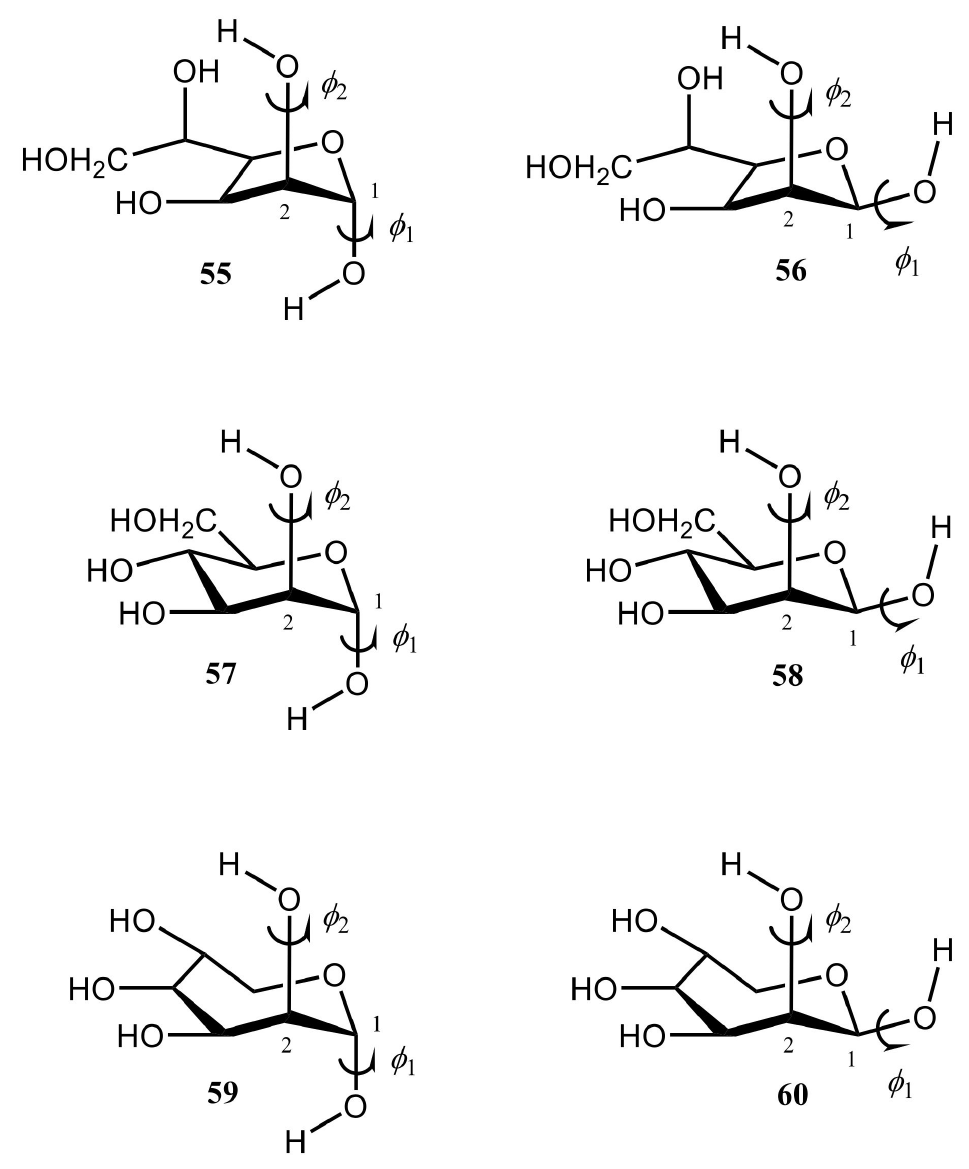
Figure 28. Structural formulas of α - and β -D-mannofuranoses ( 55 and 56 ), α - and β -D-mannopyranoses ( 57 and 58 ), and α - and β -D-mannoseptanoses ( 59 and 60 ). All rotational surfaces were characterized by the well-defined four maxima and four minima, which was due to the fact that rotation of the hydroxyl groups exercised an appre- ciable effect on 1 J (C-1,C-2) coupling constants in the furanose, pyranose, and septanose forms of carbohydrates. Undoubtedly, those dependences originated in the well-known oxygen lone pair effect on 1 J C,C [141], which should be taken into account in the confor- mational analysis of the cyclic forms of carbohydrates based on the stereospecificity of carbon-carbon coupling constants involving anomeric carbon. Stereochemical dependences of 1 J (C-1,C-2) of monosaccharides are illustrated in Table 3 for the D-forms of the most common